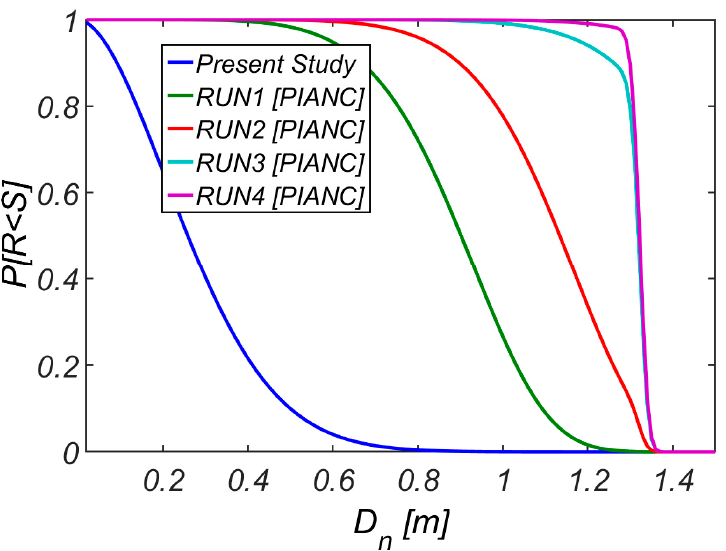
Figure 16. Failure probability of TTP as D n varies for different wave height distribution (see Table 2). Table 1. List of probabilistic properties of random variables in the Van der Meer’s formula. Variables µ